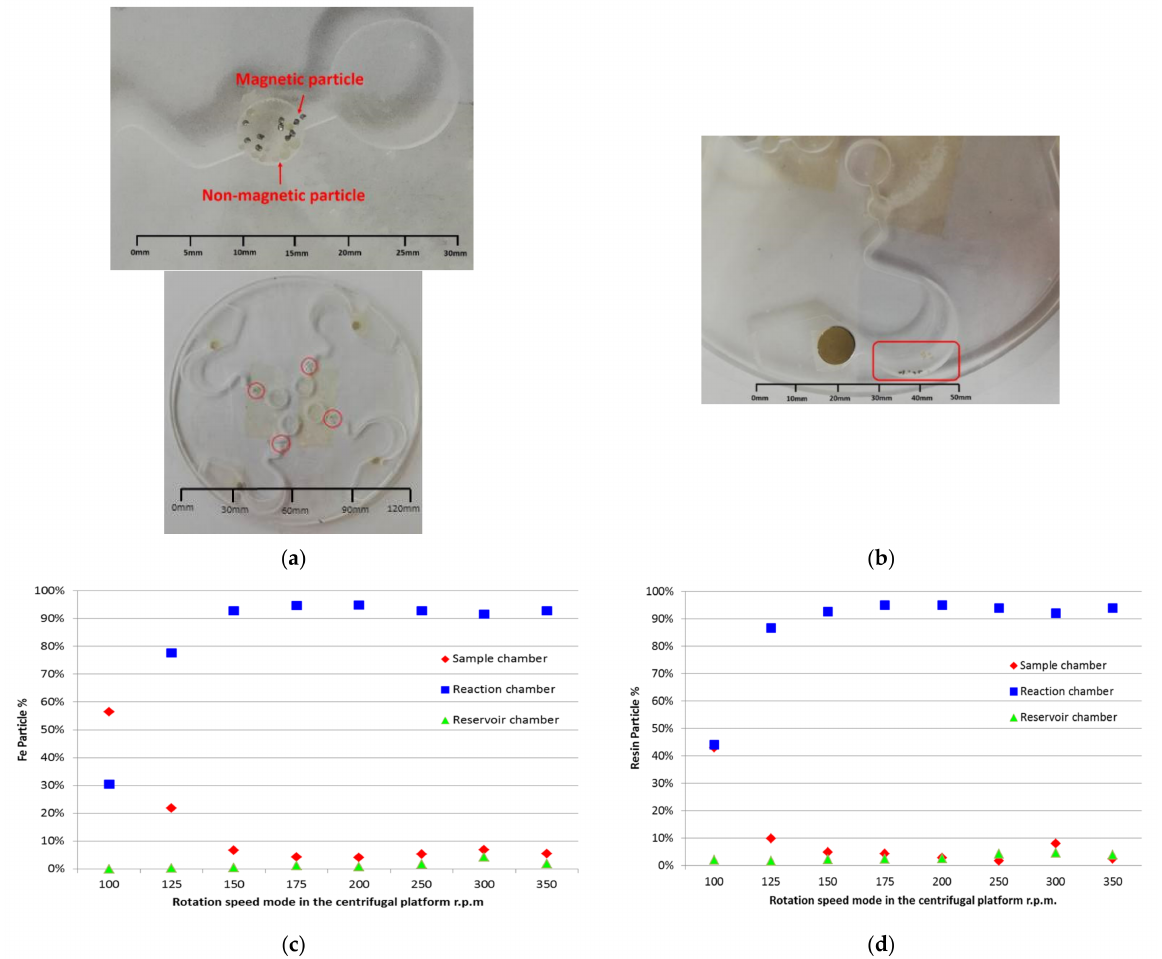
Figure 6. Ratio of magnetic and non-magnetic particles flowing to the reaction chamber under different spinning speeds of the disc in the first setting mode. ( a ) Magnetic and non-magnetic particles in the sample ready for testing. ( b ) Magnetic and non-magnetic particles flowing to the reaction chamber from the sample chamber of the disc. ( c ) Magnetic particles (Fe) flowing to the reaction chamber from the sample chamber of the disc. ( d ) Non-magnetic particles (resin) flowing to the reaction chamber from the sample chamber of the disc.